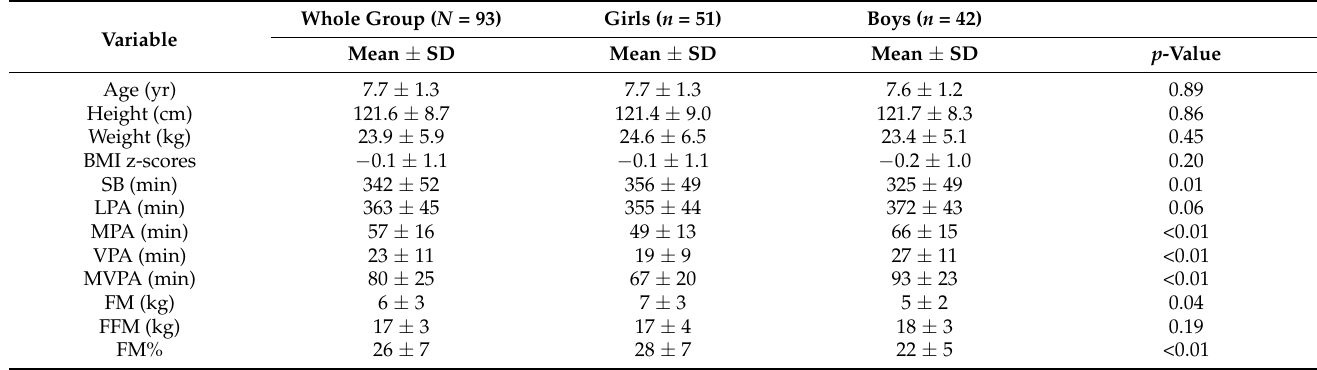
Table 1. Descriptive statistics of participants.